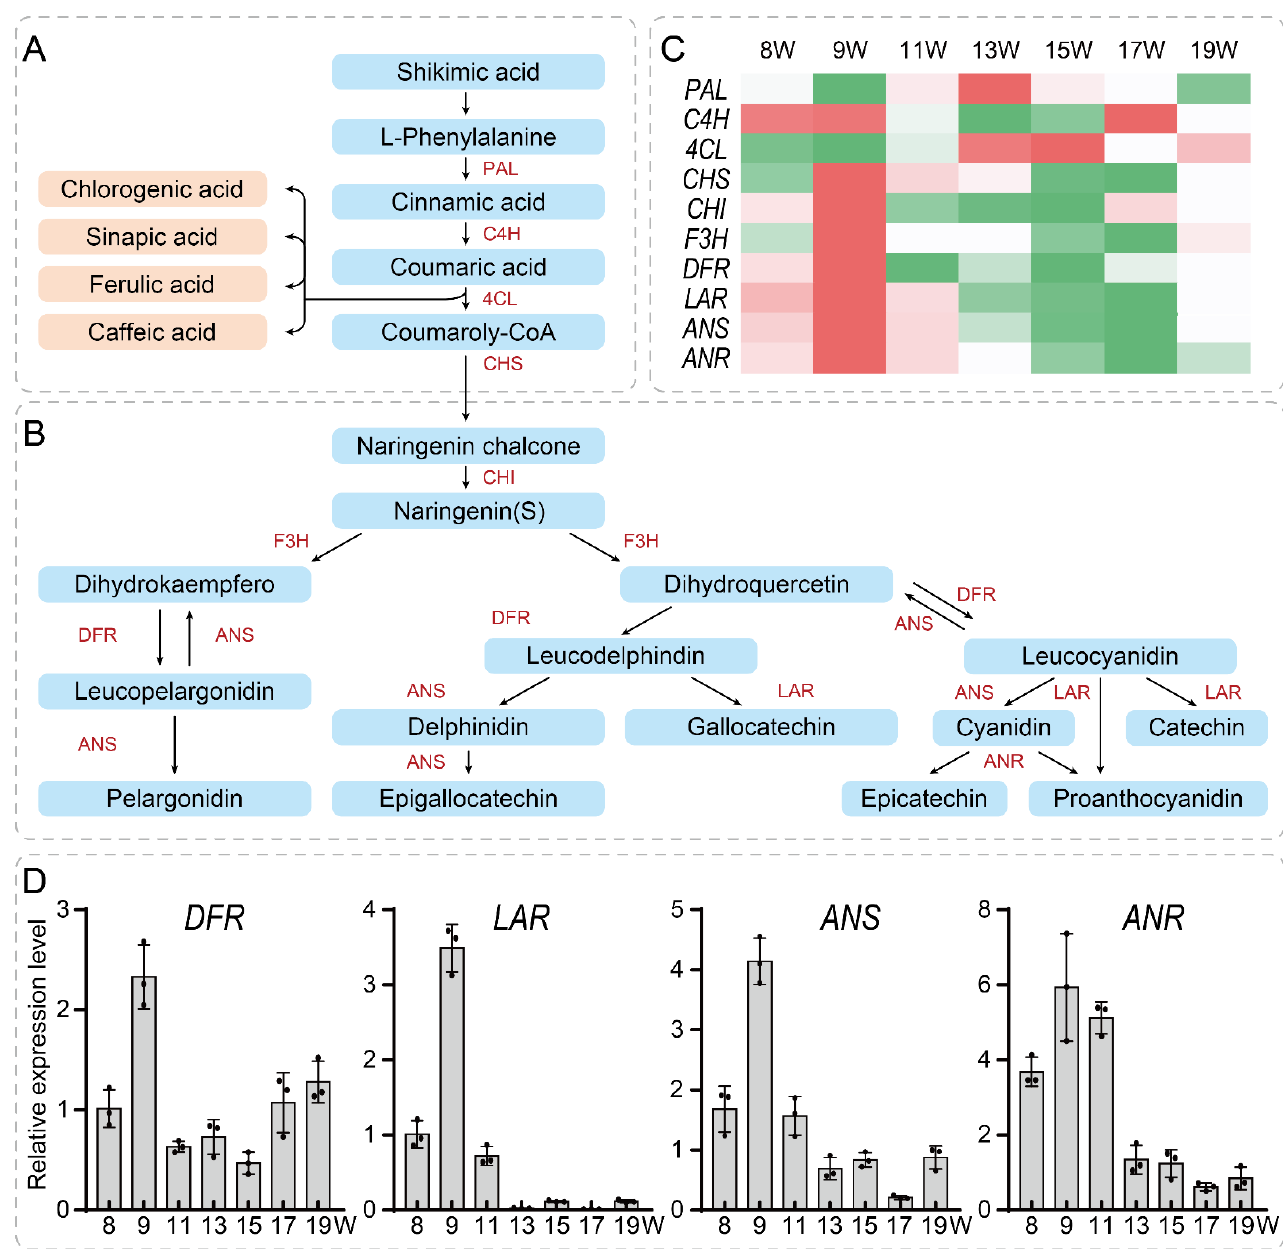
Figure 6. An overview of the phenylalanine ammonia-lyase pathway leading to the synthesis of tannin ( A , B ). The tannin signaling pathway was divided into two parts ( A , B ); ( C ) Heatmap analysis of the pression levels of key genes by RNA-seq. Red represents high expression level, and green represents low expression level; ( D ) qRT-PCR validation of expression for key candidate genes that positively regulate tannin biosynthesis. Data points were presented in the column diagram. Bars indicated for s.d. PAL: Phenylalanine ammonia-lyase; C4H: cinnamic acid 4-hydroxylase; 4CL: 4-